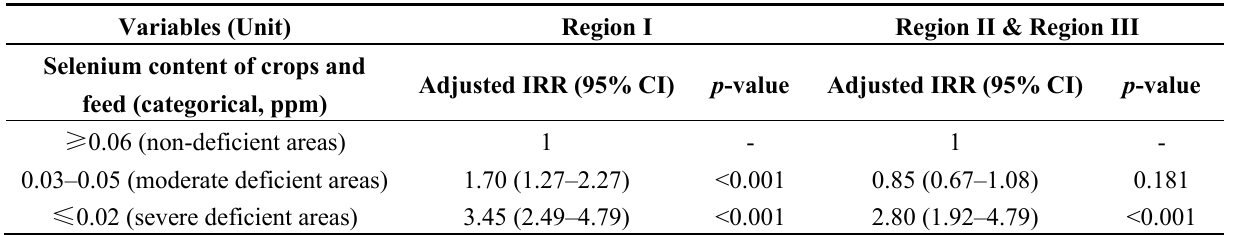
Table 2. The association between hemorrhagic fever with renal syndrome (HFRS) incidence and selenium content by multivariate Poisson regression in different climate regions, corrected for other influencing factors (not shown). Region I = temperate monsoon climate; Region II = sub-tropical monsoon climate; Region III = tropical monsoon climate. Region II and Region III were combined due to the small area of Region III. In Region IV (highland hibernal climate) and Region V (temperate continental climate), almost all cases were located in severe selenium-deficient and moderate selenium-deficient areas, except for 2 cases located in non-deficient areas in Region V, not allowing statistical analysis due to the low numbers. IRR is incidence rate ratio. CI is confidence